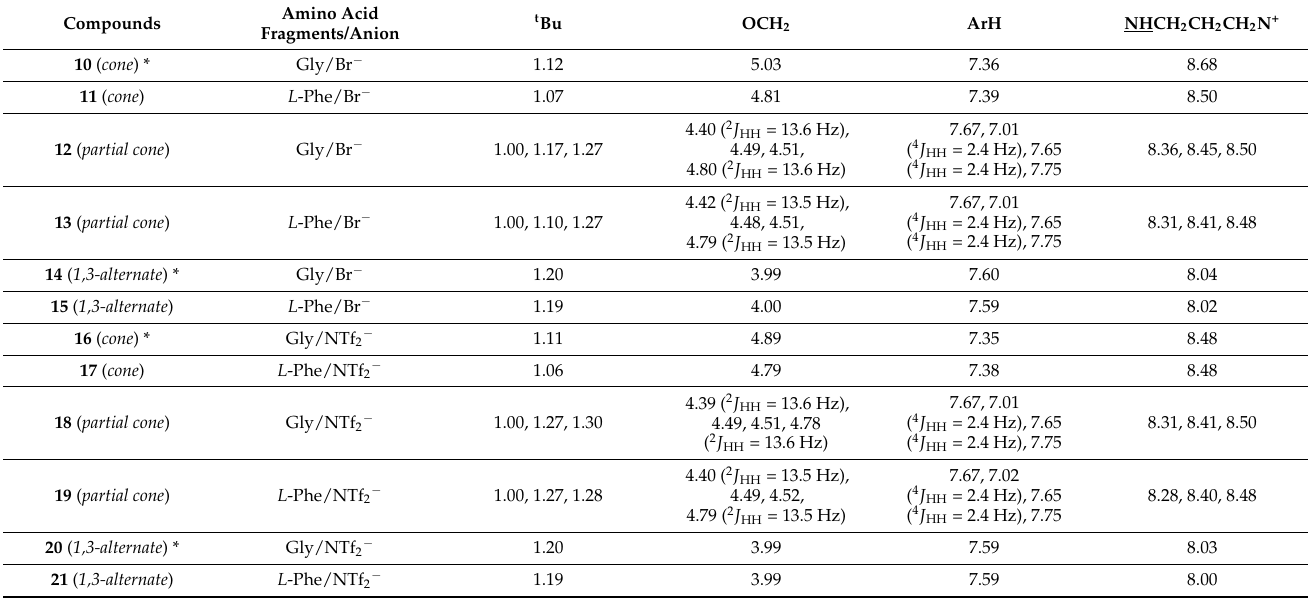
Table 1. Chemical shifts (ppm) and spin-spin coupling constants (Hz) in the 1 H NMR spectra of the compounds 10 – 21 (DMSO- d 6 , 298 K, 400